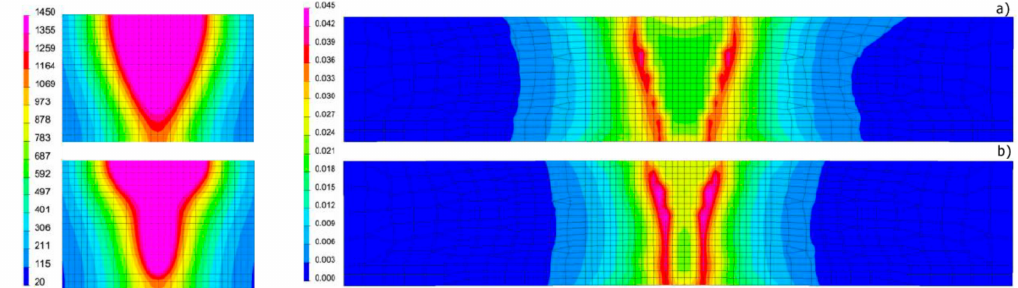
Figure 19. View of the molten pool and the distribution of cumulative plastic strains in the case of calculations for ( a ) the model without modification of the area of mesh elements loaded with the heat source and ( b ) the model developed based on the proposed modification for the DL_T3 sample (Table 3).